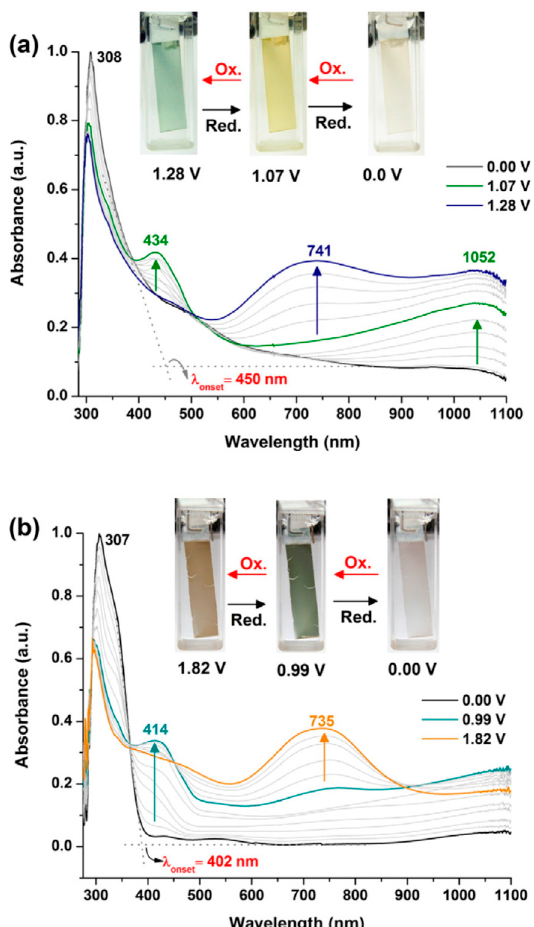
Figure 13. Electrochromic study of the ( a ) P(PhCz-2Cz) and ( b ) P(TPA-2Cz). Reproduced with permission from [143]. Copyright (2015) Elsevier.